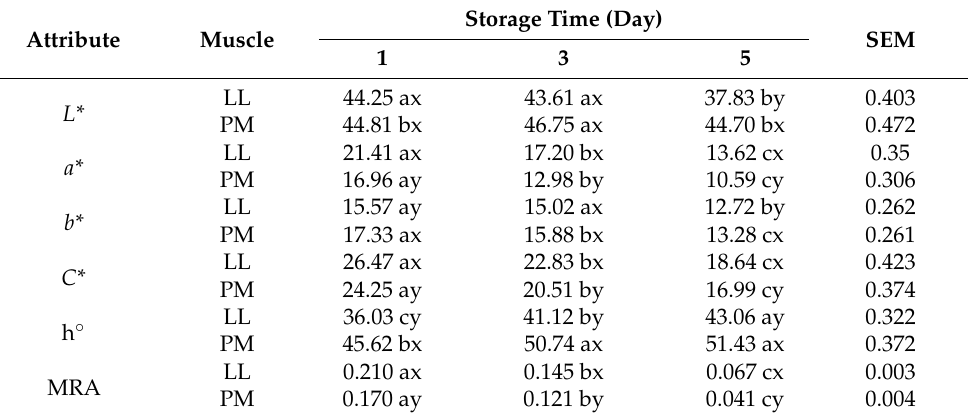
Means in rows with different superscripts (a–c) are different ( p < 0.05) and means in column for LL and PM for each storage time and attribute with different superscripts (x–z) are different ( p < 0.05). (a) SEM, standard error of the mean. (b) C* (Chroma) = ( a* 2 + b* 2 ) 0.5 . (c) h ◦ (Hue angle) = ATAN( b* / a* ) × (180/ π